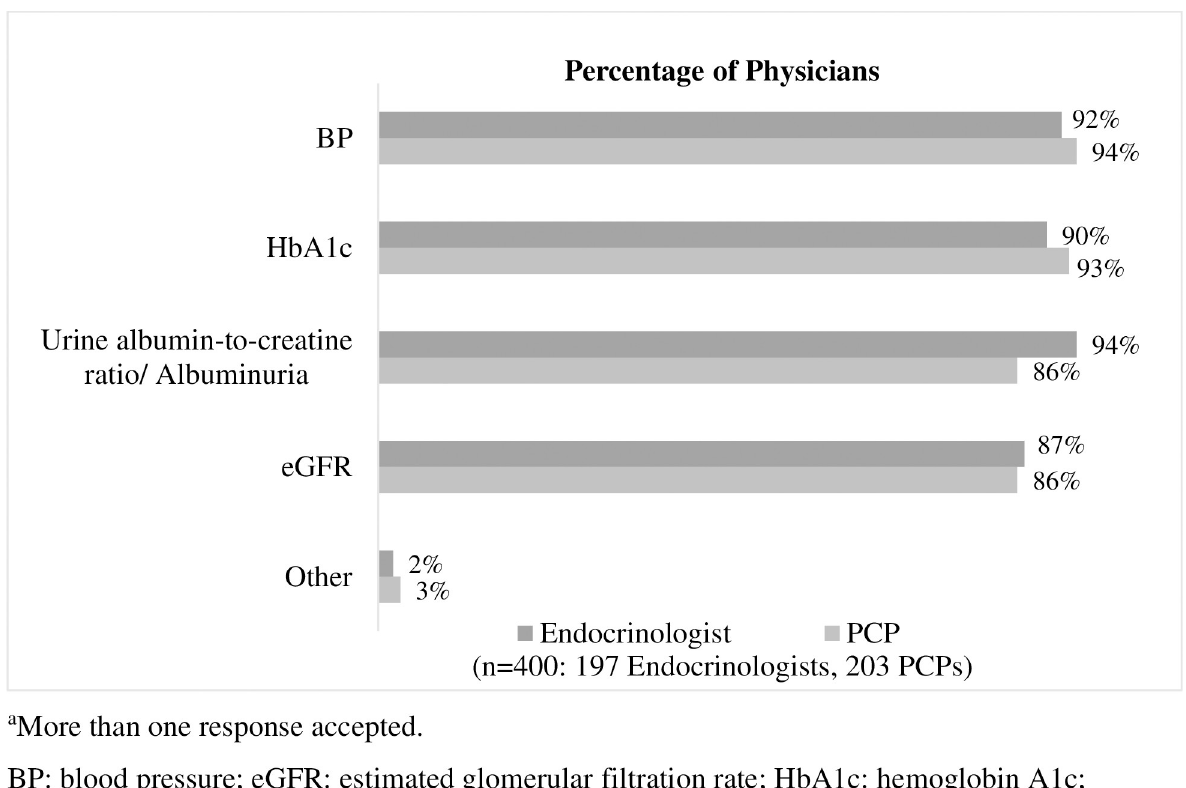
Fig 2. Tests conducted in type 2 diabetes mellitus patients at low risk of developing diabetic kidney